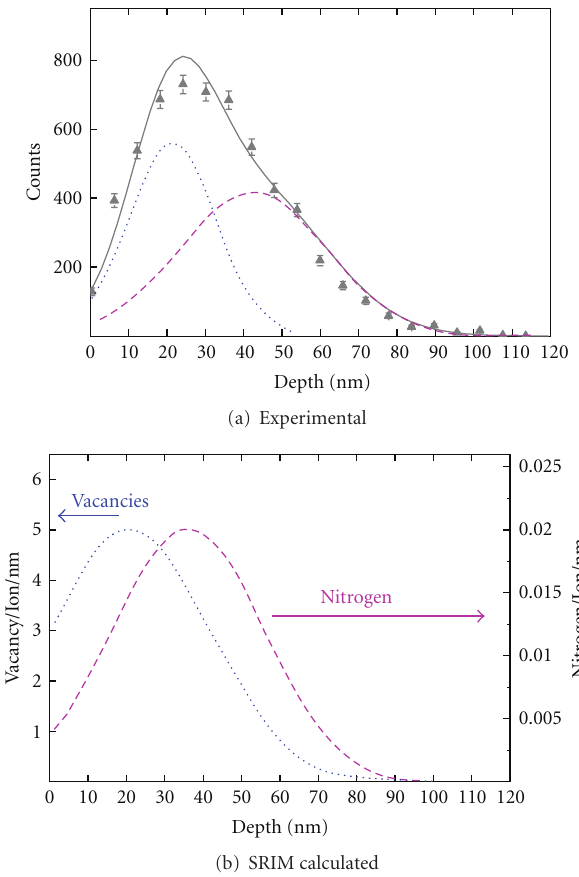
Figure 1: (a) Experimental depth profile of 15 N implanted in steel to a fluence of 5 × 10 15 N/cm 2 obtained using RNRA. The experimental data points (closed triangle) are fitted into two Gaussians whose peaks are centered at ∼ 20 nm (dotted line) and 42nm (dashed line). (b) SRIM simulation of 30keV nitrogen in steel depicting the implanted ion and vacancy profiles.